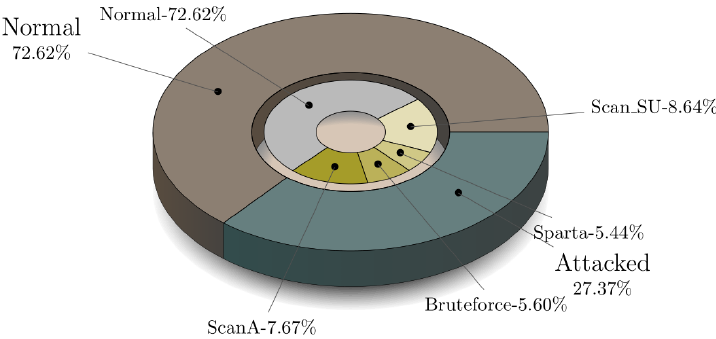
Figure 7. Five files statistics of